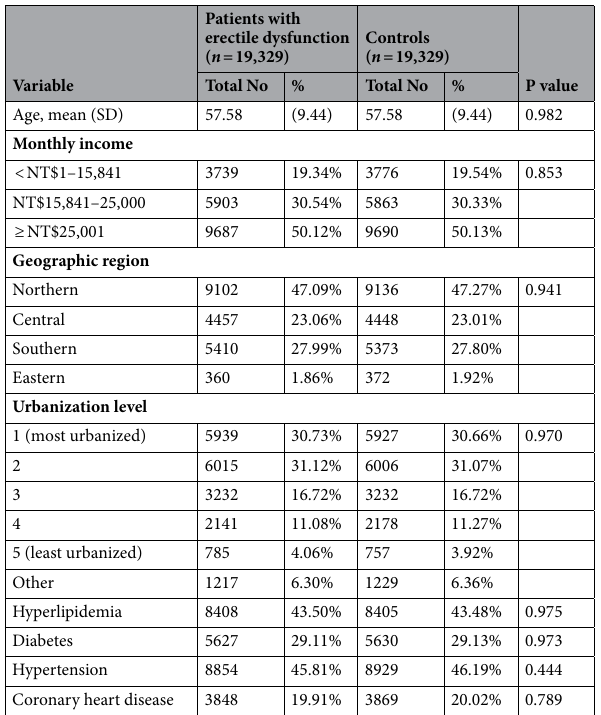
Table 1. Demographic characteristics of patients diagnosed with erectile dysfunction during 2016–2017 and control patients in Taiwan (n = 38,658).